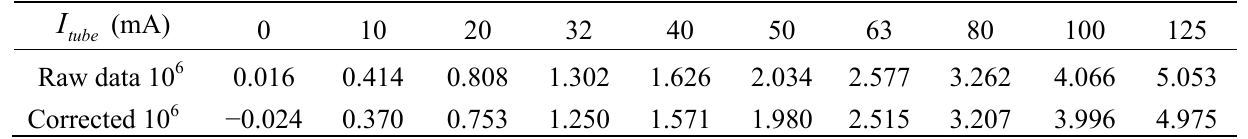
Table 7. Channel 371 s raw data and corrected data, 90 kV, 500 us